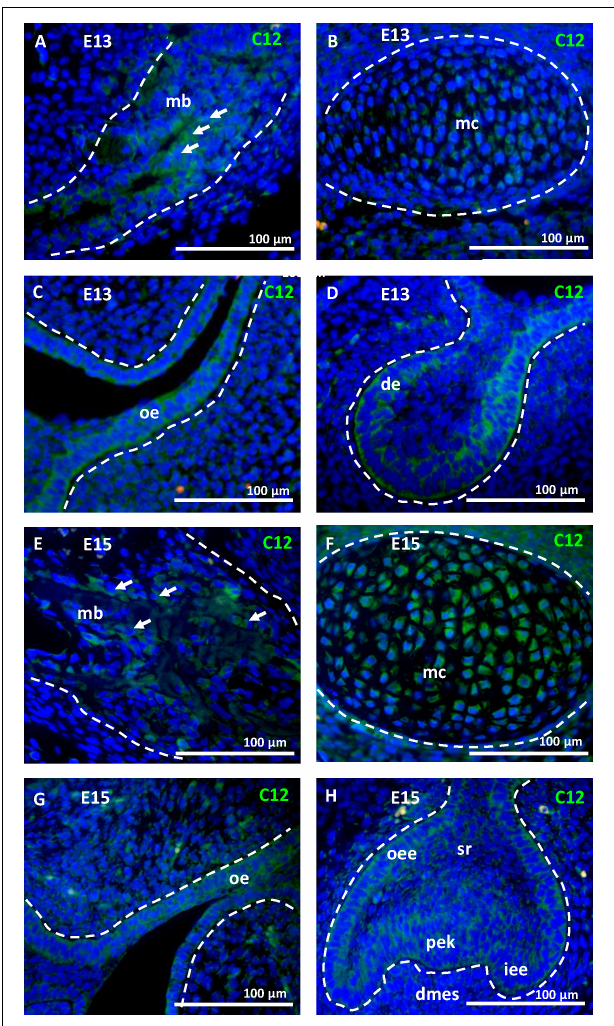
FIGURE 2 | Caspase-12 protein in prenatal development. Immunofluorescence analysis of caspase-12 (green) in developing mandibular bone and adjacent structures of the lower jaw. Caspase-12 at the stage E13 was localized in the mandibular bone (A) , Meckel’s cartilage (B) , oral epithelium (C) , and first lower molar (D) . Caspase-12 positivity at the stage E15 was localized in the mandibular bone (E) , Meckel’s cartilage (F) , oral epithelium (G) , and developing first lower molar (H) . Scale bar: 100 µ m, counterstained by DAPI (blue). Arrows point to osteoblasts. mb, mandibular bone; mc, Meckel’s cartilage; oe, oral epithelium; de, dental epithelium; oee, outer enamel epithelium; dmes, dental mesenchyme; iee, inner enamel epithelium; sr, stellate reticulum; pek, primary enamel